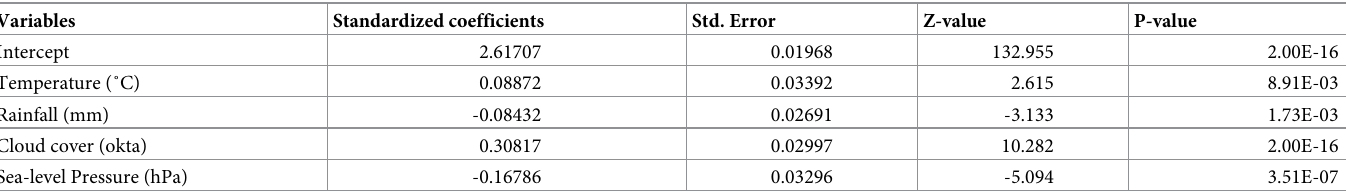
Table 3. Parametric coefficients and fit indicators of the final model when including only the variables filtered with the stepwise procedure.